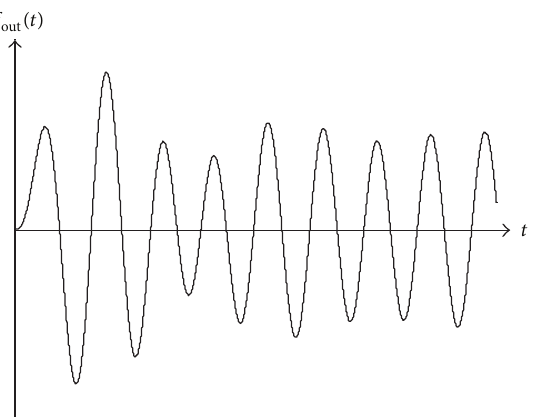
Figure 4: Possible establishing of the situation shown in Figure 3 through beats while adjustment of the frequency. We can interpret resonance as “filtration” of the beats when the resonant frequency is